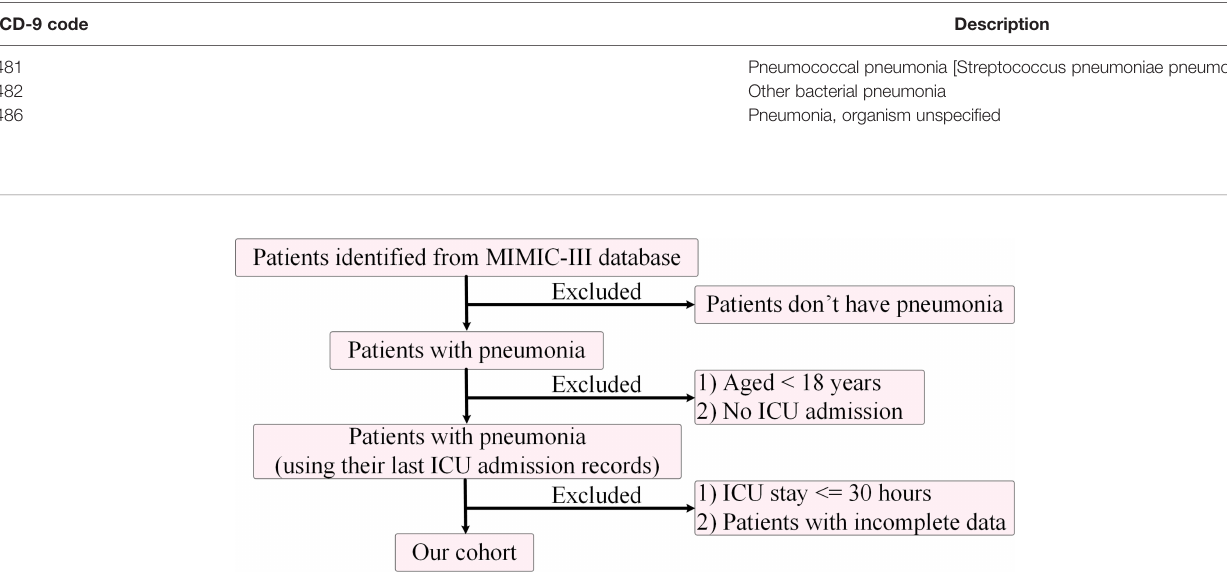
TABLE 1 | ICD-9 codes used in this study for pneumonia.